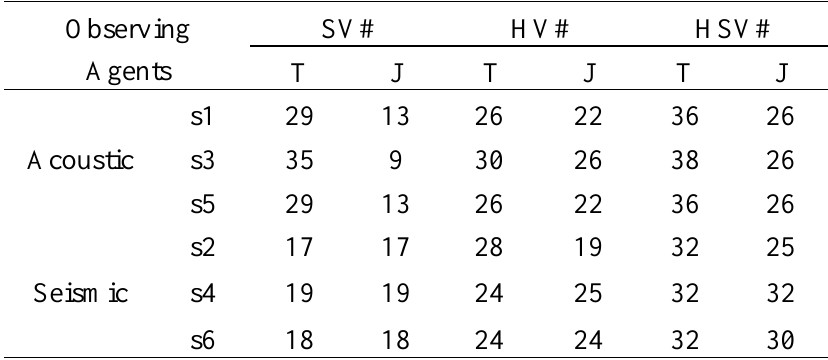
Table 2. The numbers of support vectors, hull vectors and their unions.